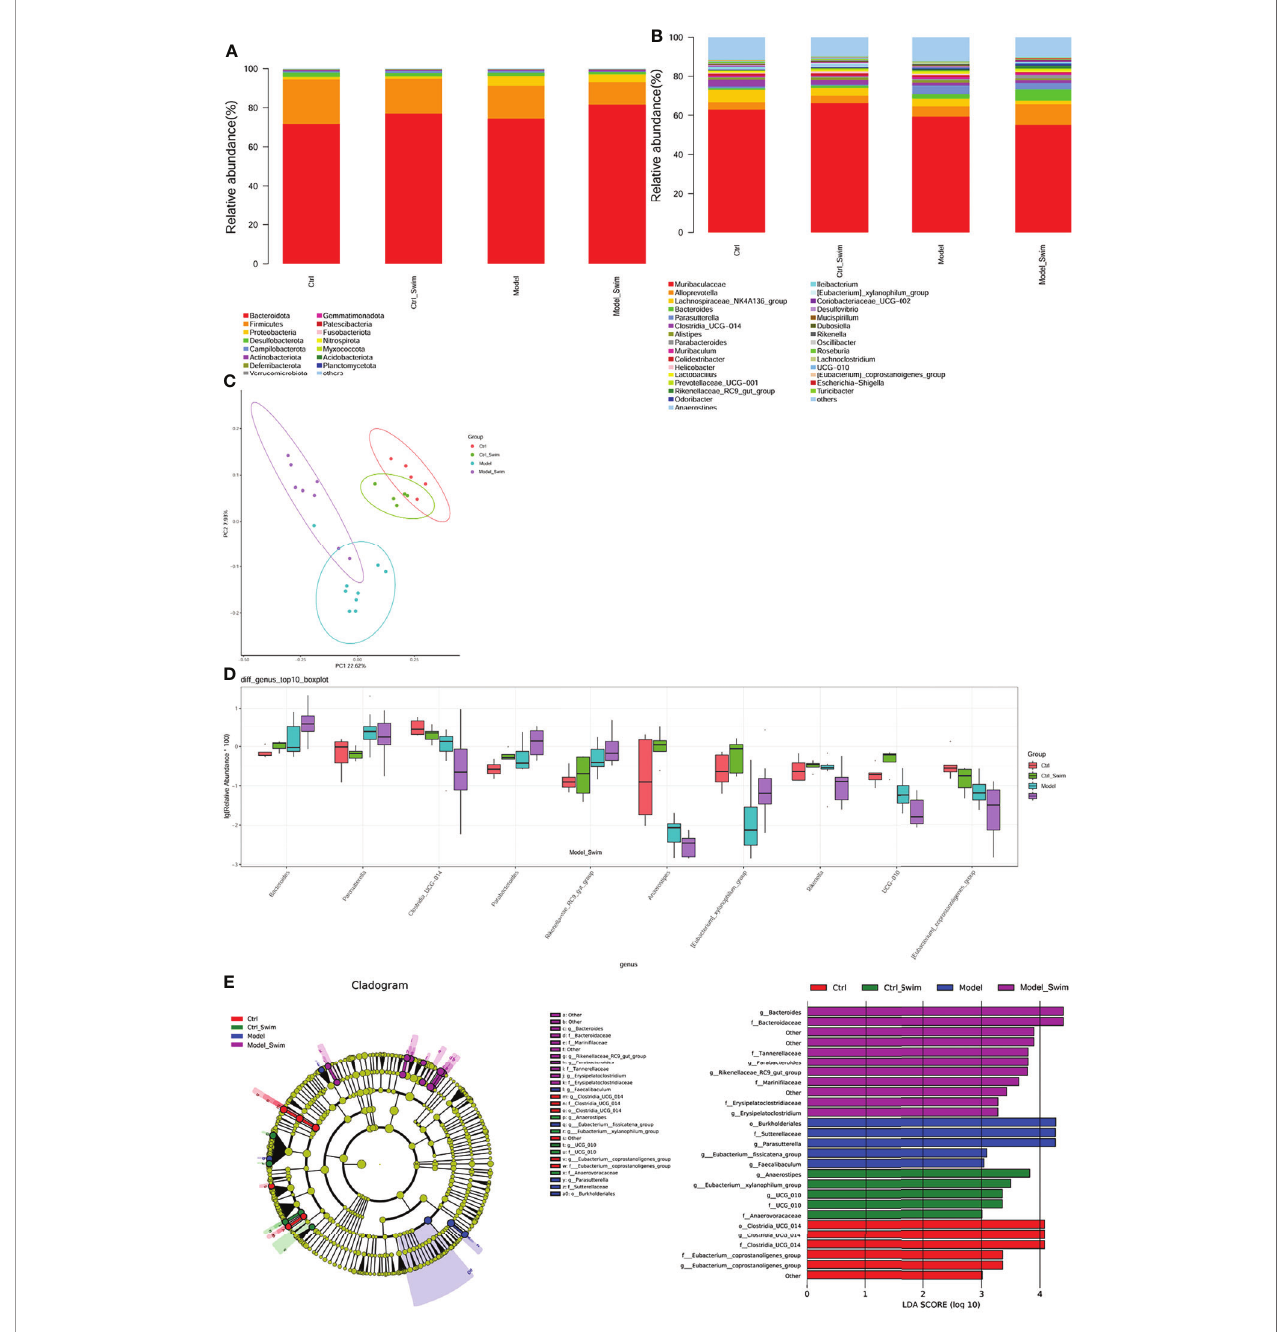
FIGURE 4 | Alteration of fecal microbial community composition caused by swimming pretreatment in AOM/DSS-induced CAC Mice. (A) , Relative abundance in each group for the major bacterial phylum. (B) , Relative abundance of the main bacterial genus in each group. (C) , Fecal microbial community diversity analyses. Binary jaccard-based PCoA plot base of the relative abundance of OTUs displaying bacterial structural clustering. (D) , The top 10 genera with signi fi cant differences for relative abundances among the Model, Model_Swim, Control and Control_Swim groups; Kruskal – Wallis, all p < 0.05. (E) , Analysis of the different species composition among the Model, Model_Swim, Control and Control_Swim groups by